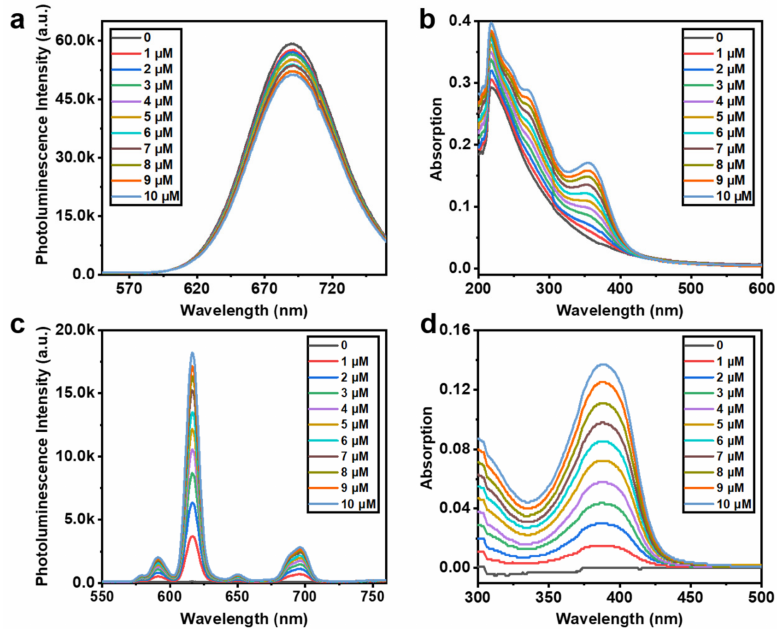
Figure 4. Photoluminescence and absorption spectra of CdTe QDs ( a,b ) and Eu 3+ ( c,d ) upon the addition of different concentrations of OTC in the range of 0 to 10 µ M with the concentration interval of 1 µ